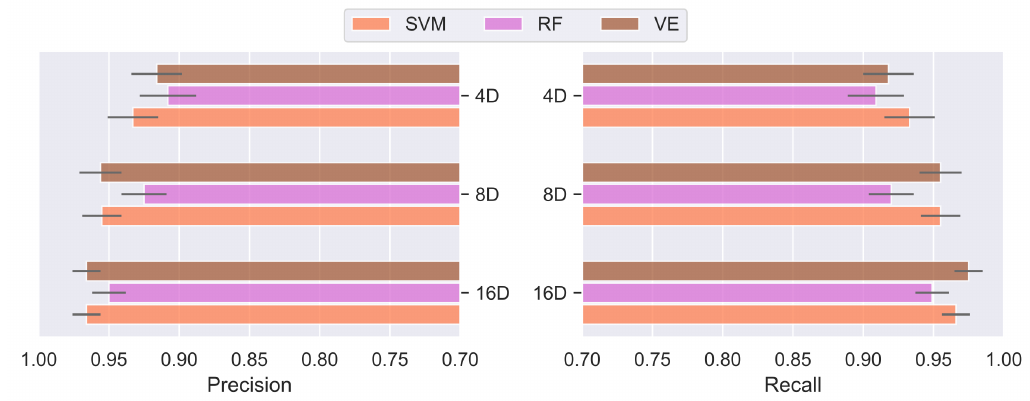
Figure 14. Classifiers sensitivity to the increasing severity of the autoencoder’s dimensionality reduction.